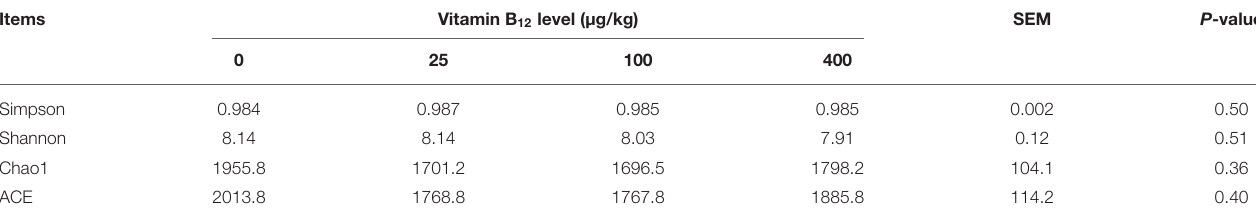
TABLE 5 | Effects of dietary supplementation of vitamin B 12 on the cecal microbial diversity in laying hens * . Items